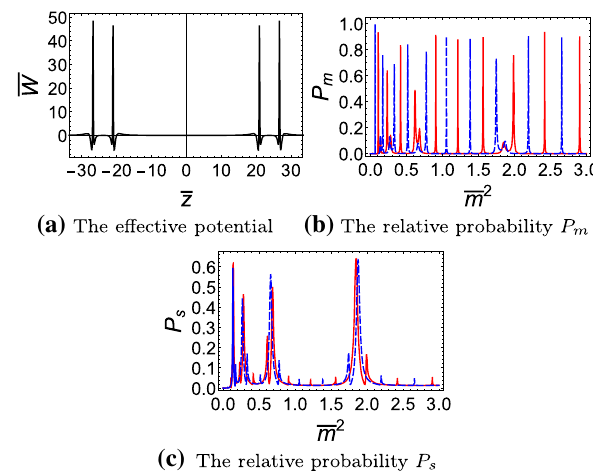
Fig. 21 The effective potential, the relative probabilities of the even parity KK mode ψ e (dashed blue lines) and the odd parity KK mode ψ o (solid red lines) quasi-localized between the sub-wells P m and in the sub-wells P